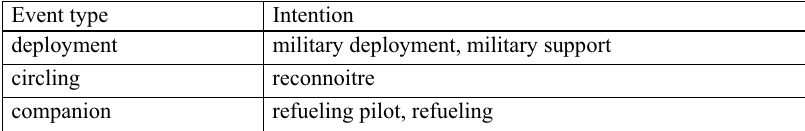
Table 2. The relationship of event type and operational intention.